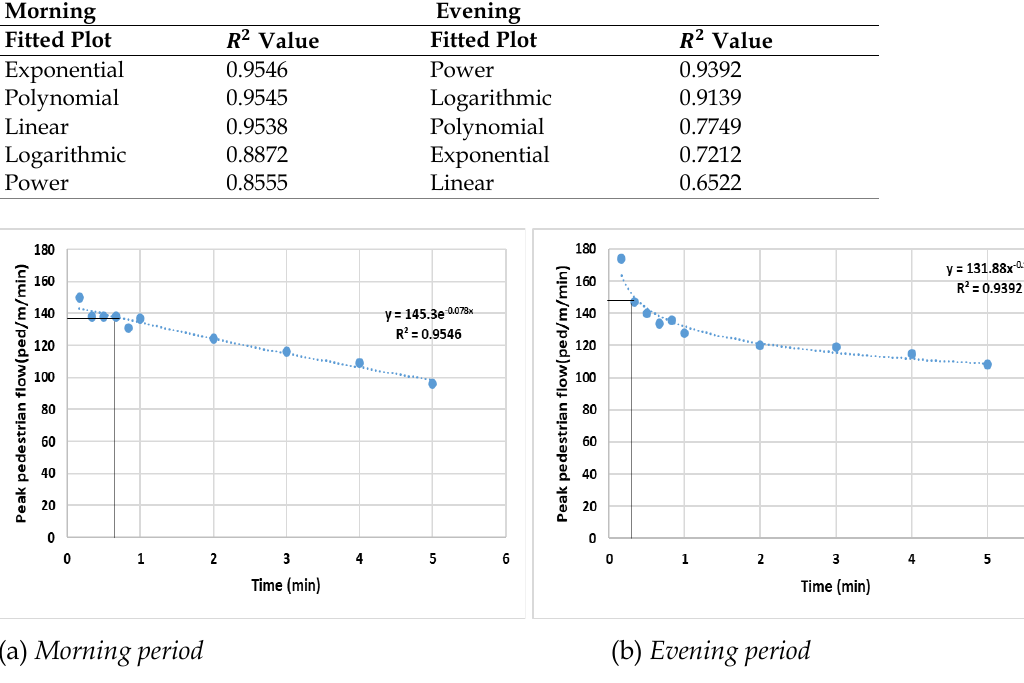
Figure 5. Variation in Peak Pedestrian Flow with Data Extraction Count Interval Further, analysis was done to examine if any count interval between 20s and 40s can be used for data extraction. This was done through hypothesis testing. Peak flows observed during 20s-, 30s- and 40s-time interval were compared. The hypothesis was: Null Hypothesis: The difference in mean of peak flow values for two count intervals is